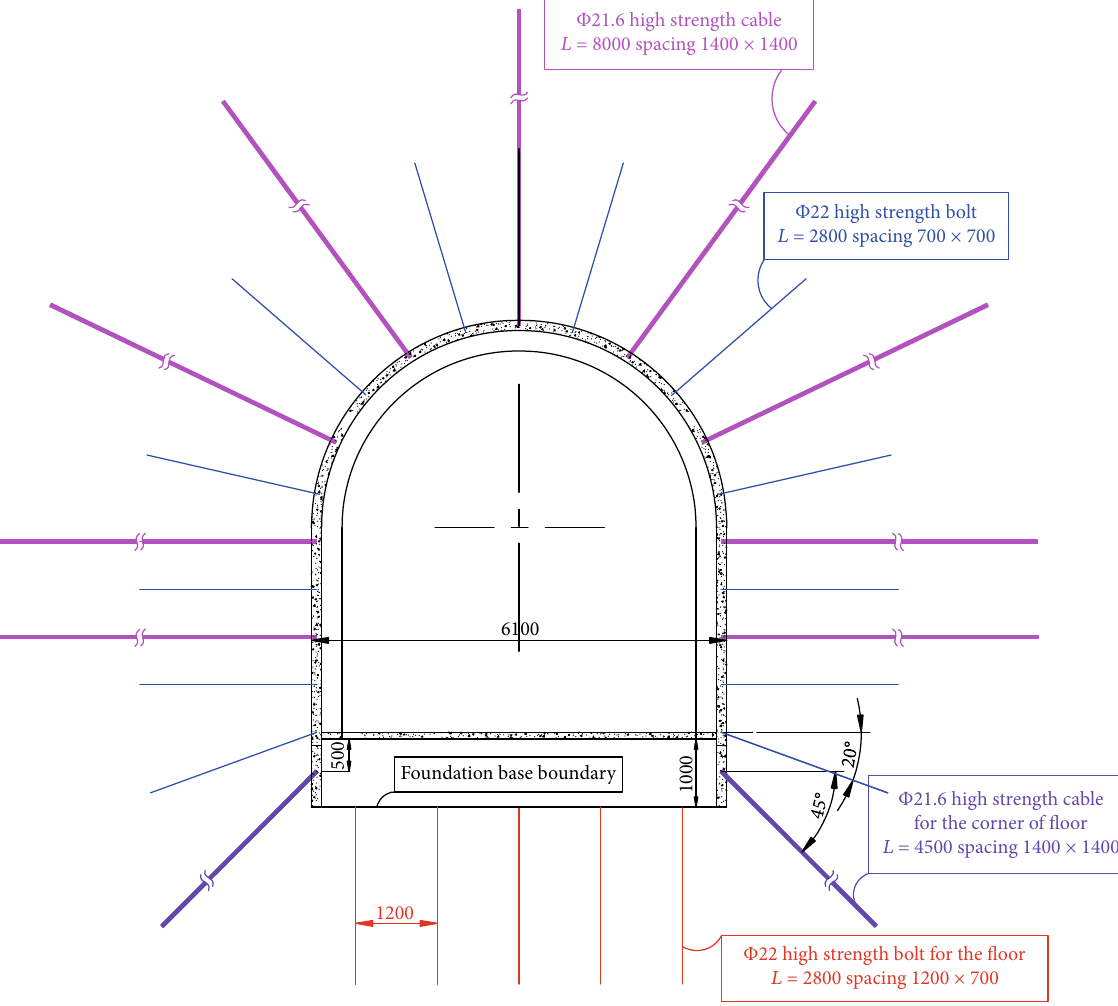
Figure 6: Deep hole (6 m) grouting